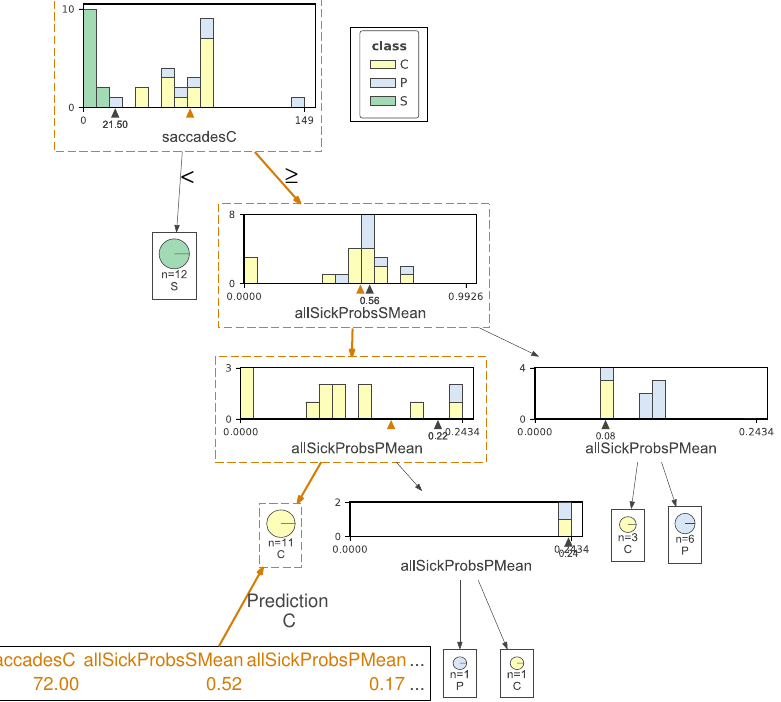
Figure 8. One presymptomatic register wrongly classified as control by a decision tree. The features involved in the decision appear at the bottom of the